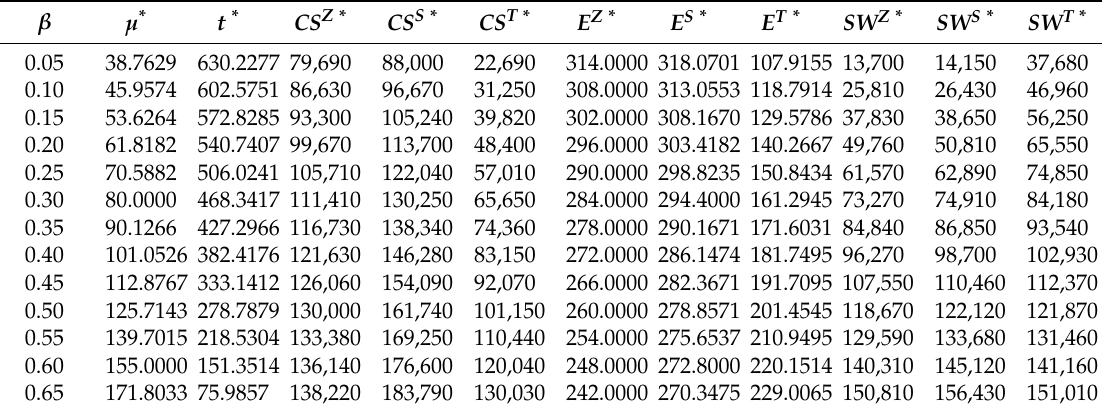
Table 3. The influence of green consumers when the government implements the double